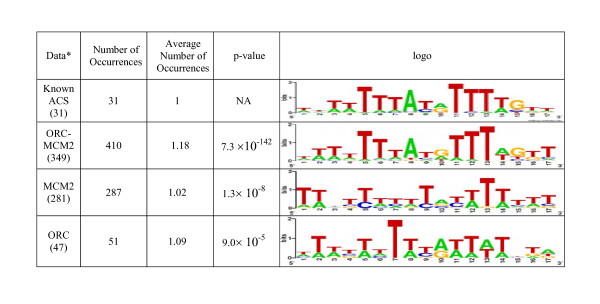
De novo motif finding within ORC-MCM2, MCM2-only and ORC-only sites. *Numbers in parentheses refer to the number of input sequences in each set. "Known ACS" denotes an alignment of 31 ACSs identified by mutation analysis and is provided for comparison. The sequence logo was generated using Weblogo [65].